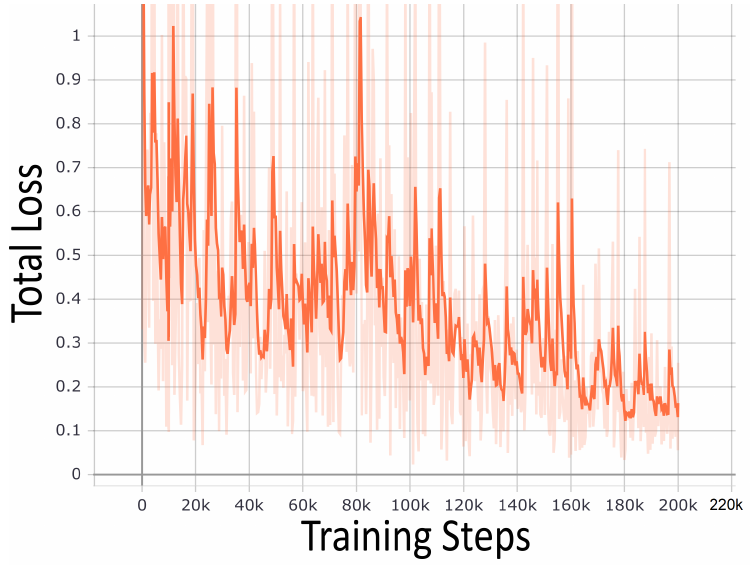
Figure 2. Absolute loss diagram of the developed data